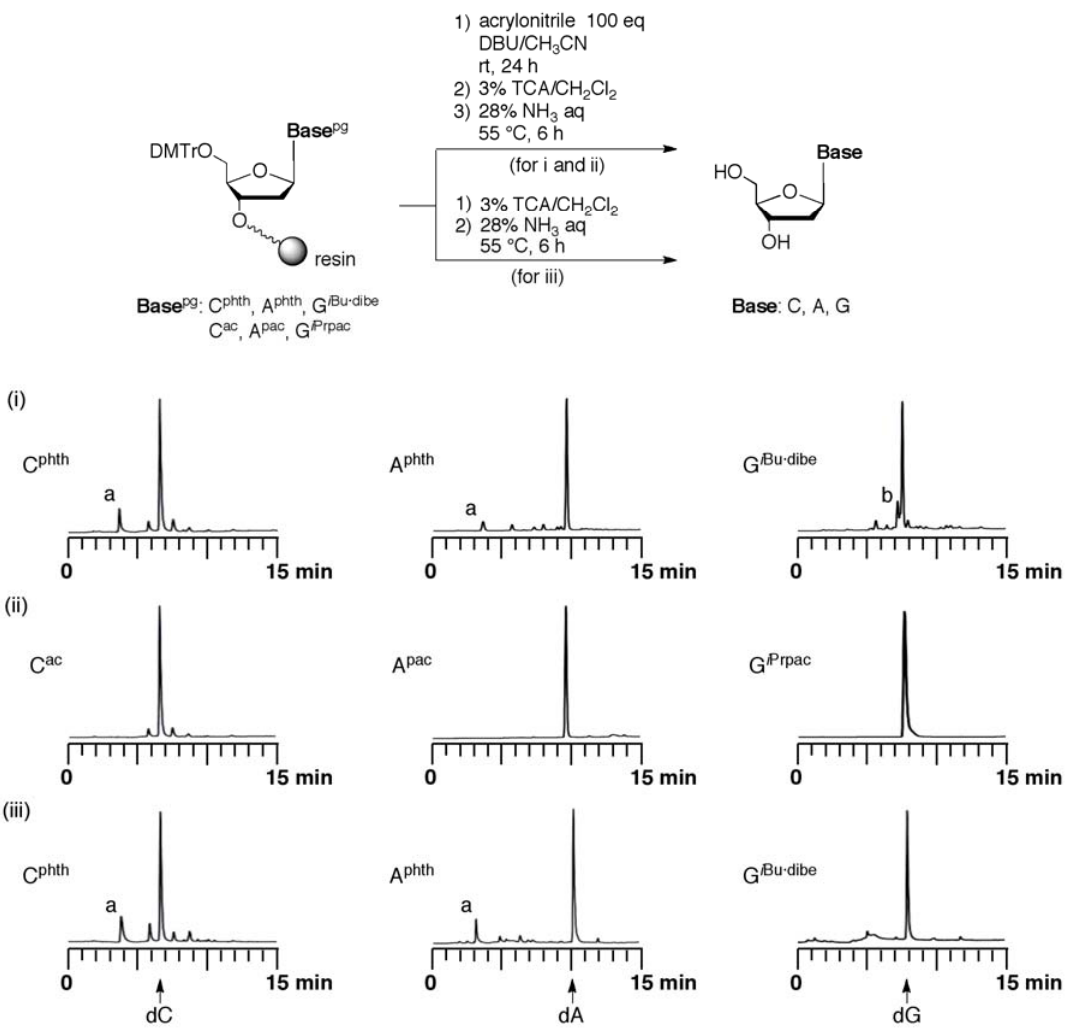
Figure 3. Analysis of cyanoethylation of (i) the fully protected monomers (C phth , A phth ,